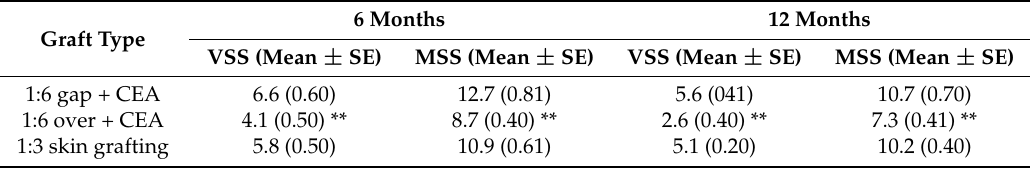
Table 1. The Vancouver Scar Scale (VSS) and the Manchester Scar Scale (MSS), at 6 and 12 months among gap 1:6 mesh plus CEA, over 1:6 mesh plus cultured epithelial autografts (CEA), and 1:3 mesh.